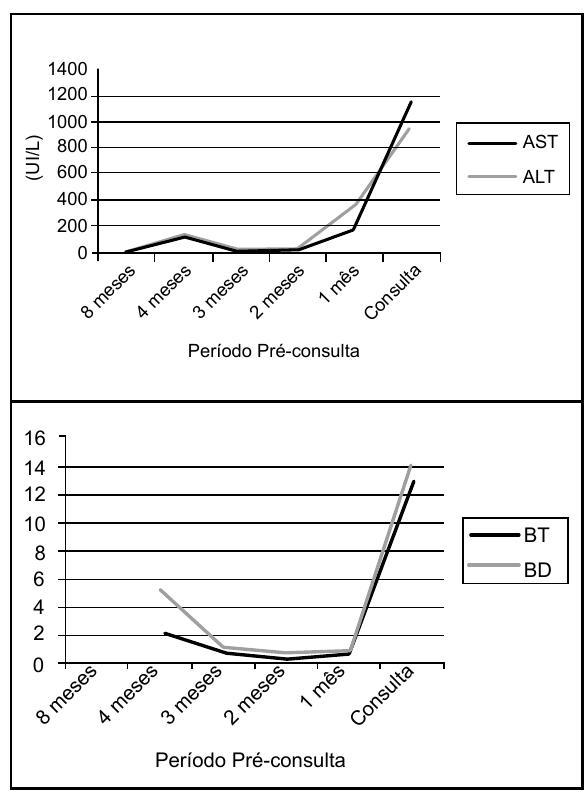
Figuras 4 e 5 – Resultados laboratoriais do caso #2 – exames anteriores ao acom-